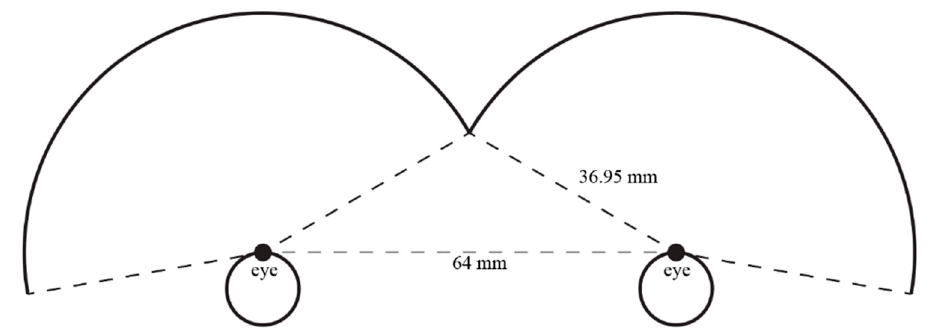
Figure 11. A binocular near-eye display with a maximum radius of curvature, given the average distance between human adult male eyes.